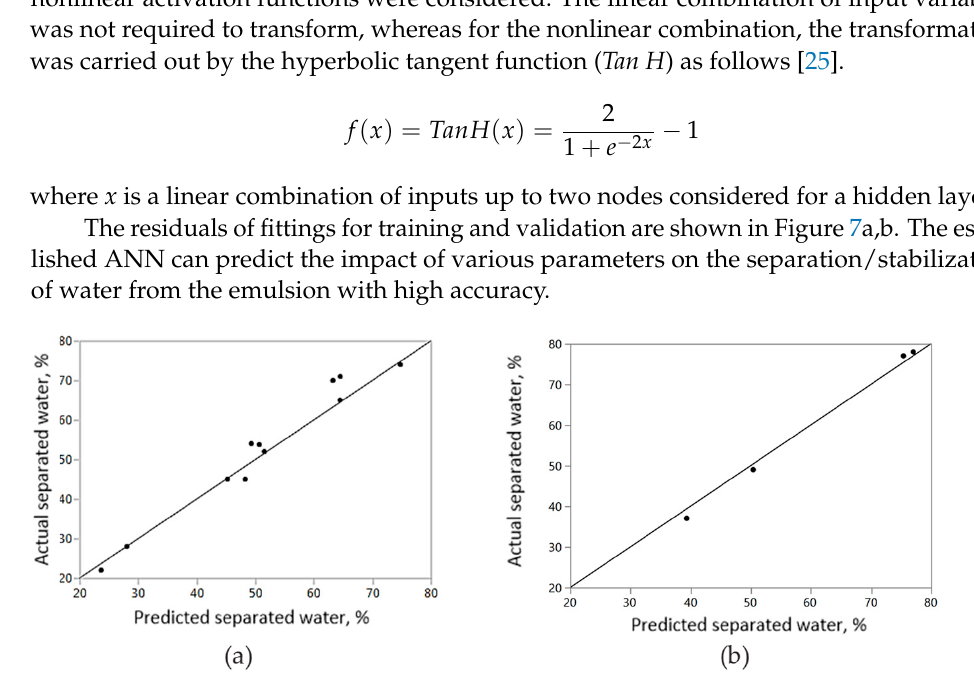
Table 7. Sensitivity of the training and validation parameters.